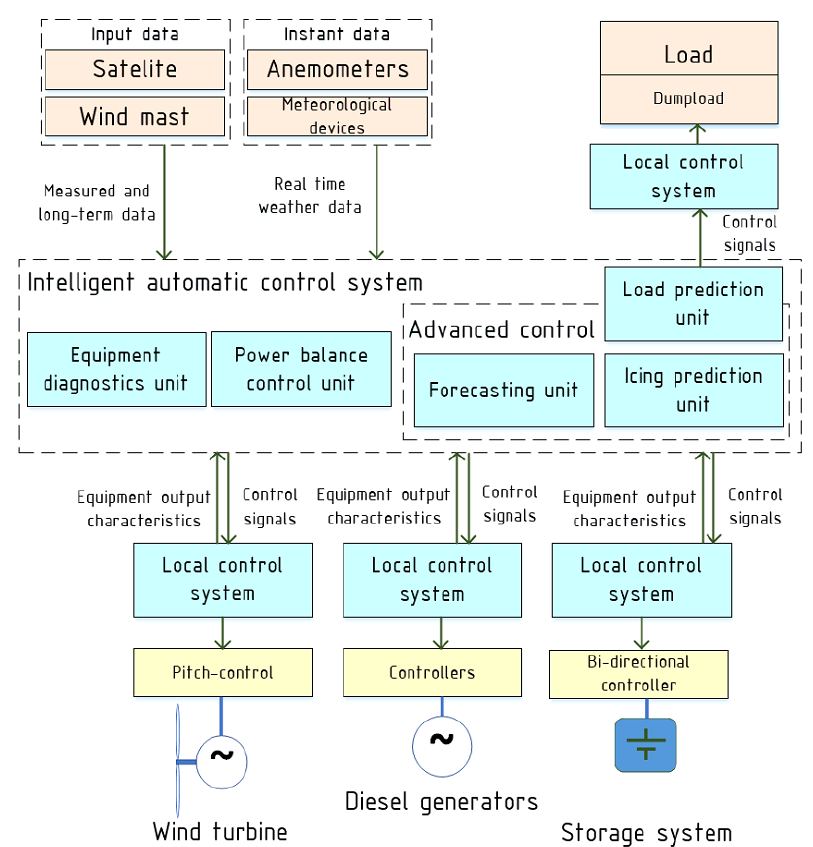
Figure 1. Functional diagram of IACS.